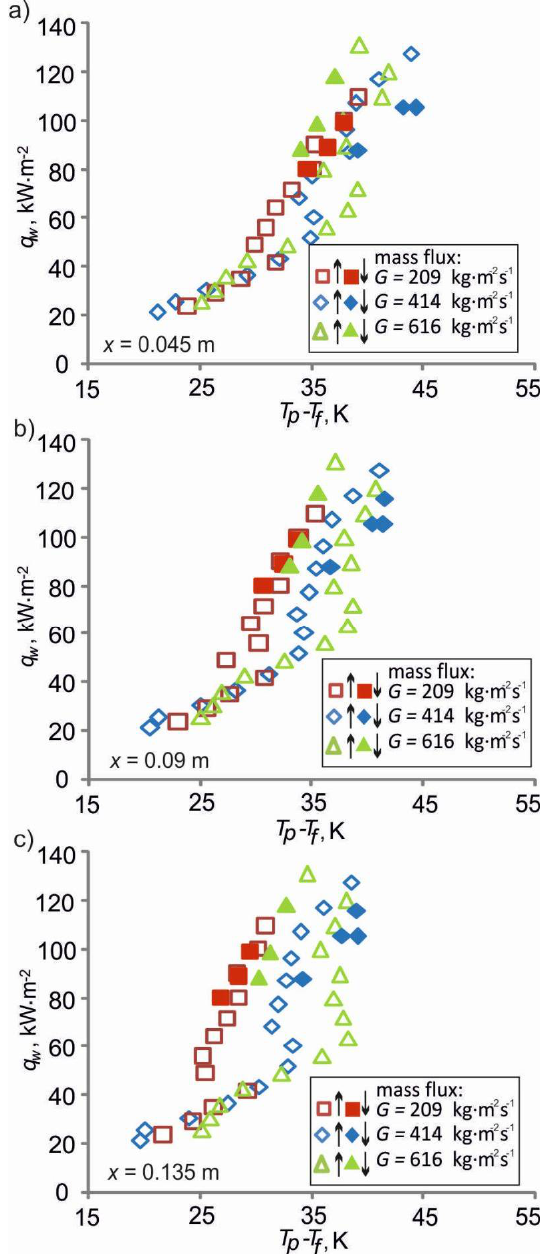
Fig. 6. Boiling curves generated for selected distances from the minichannel inlet (0.045 m, 0.09 m and 0.135 m) for three mass fluxes, constructed similarly as in Fig.